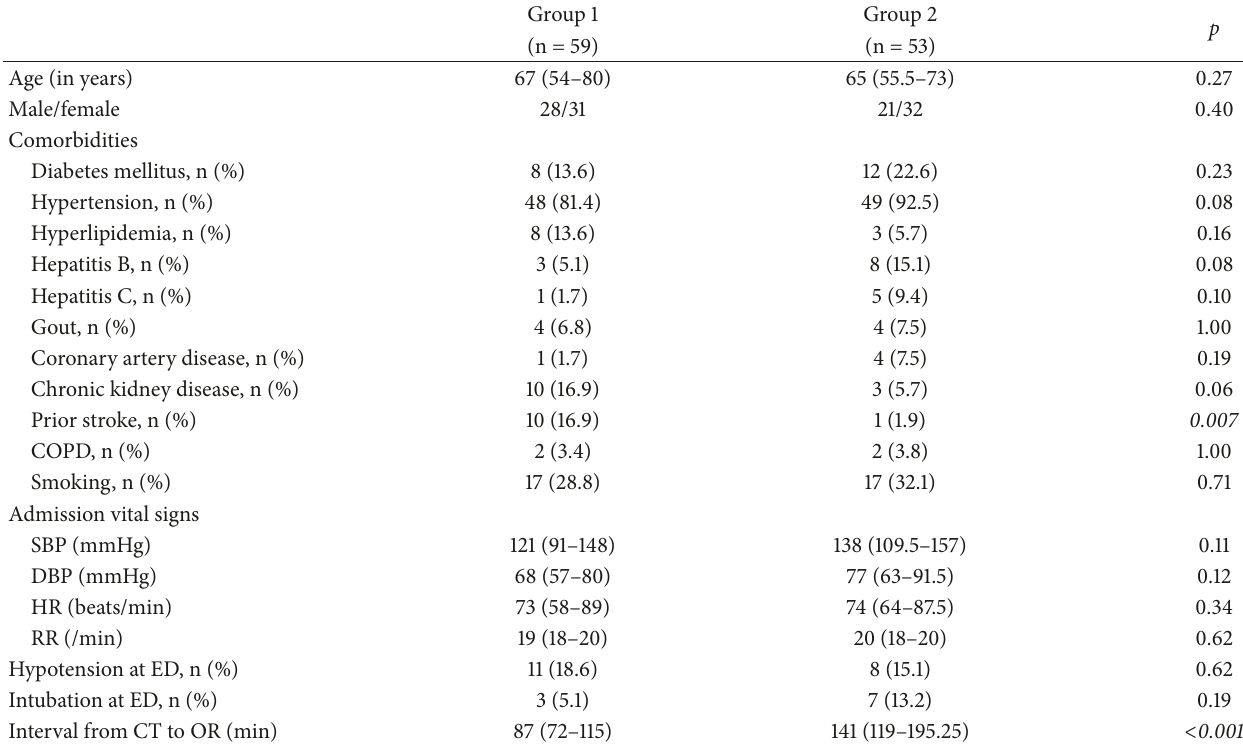
Table 1: Preoperative baseline and clinical